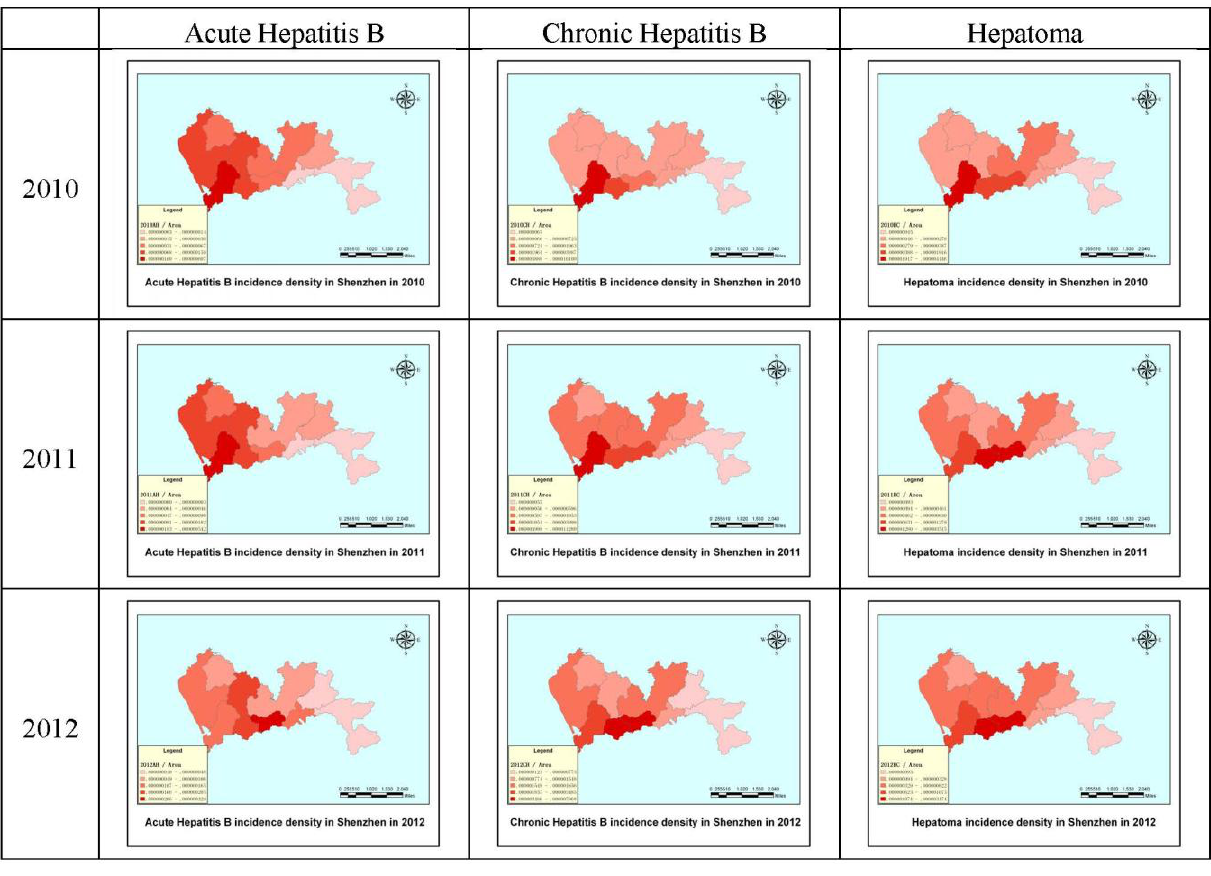
Figure 5. The incidence densities of acute hepatitis B, chronic hepatitis B and hepatoma in Shenzhen in 2010, 2011 and